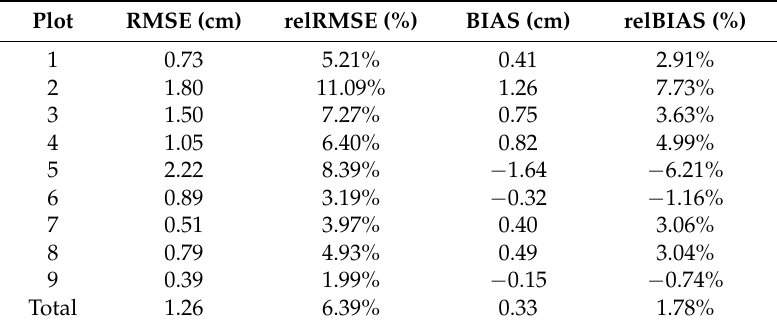
Figure 18. The errors of DBH observations for different DBH values. Table 3. Accuracy of the DBH estimations using the SLAM smartphone.